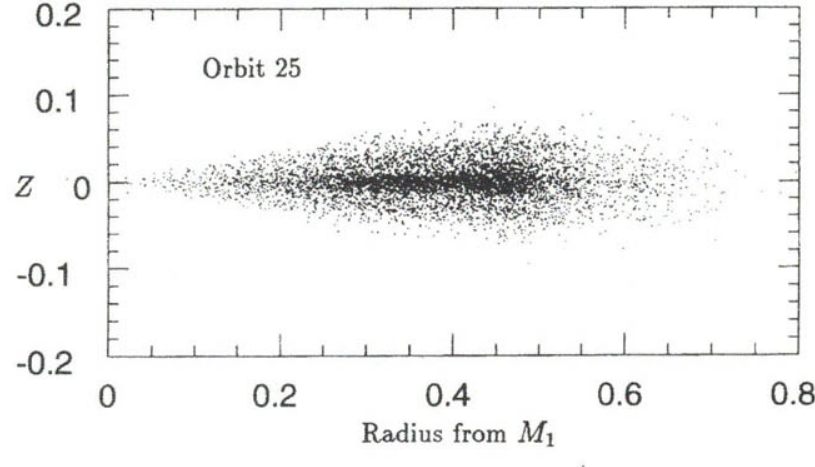
Fig. 2. Disk profiles of the disk height versus radial distance from Mi at the end of orbit 25. Note the thin nature of the disk and the high density at the circularization